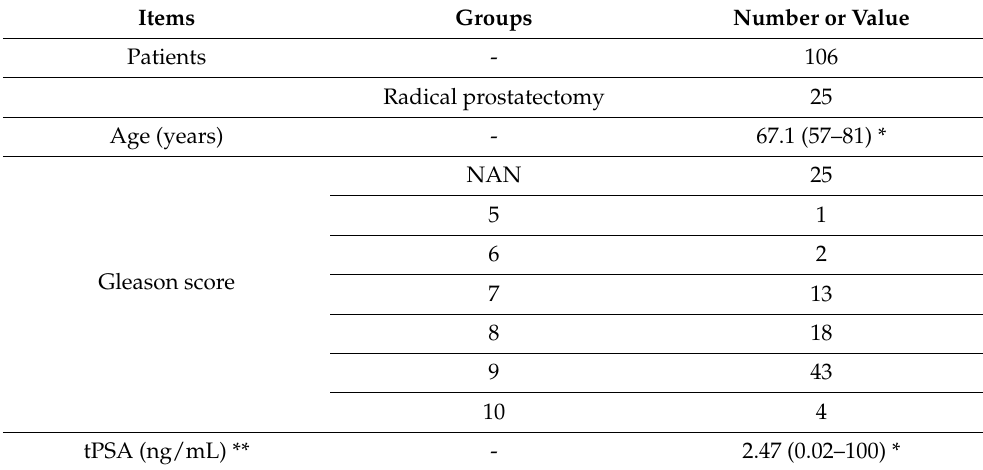
Table 1. Patients’